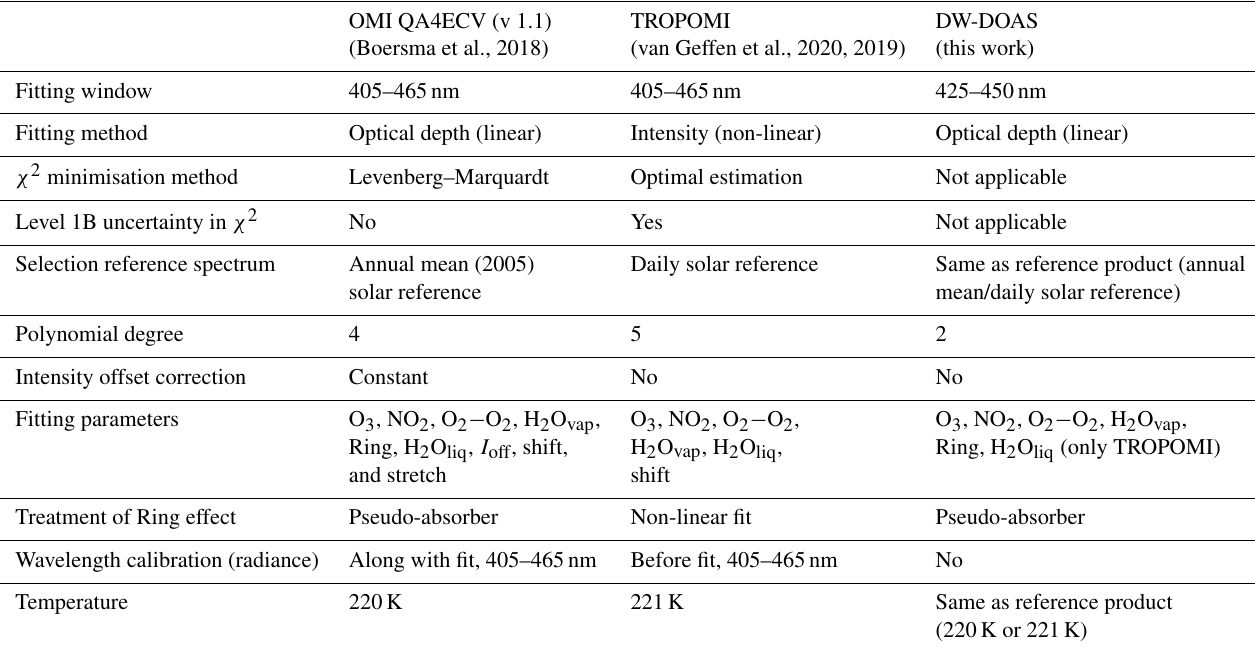
Table 1. NO 2 SCD retrieval details for OMI and TROPOMI reference products and DW-DOAS.